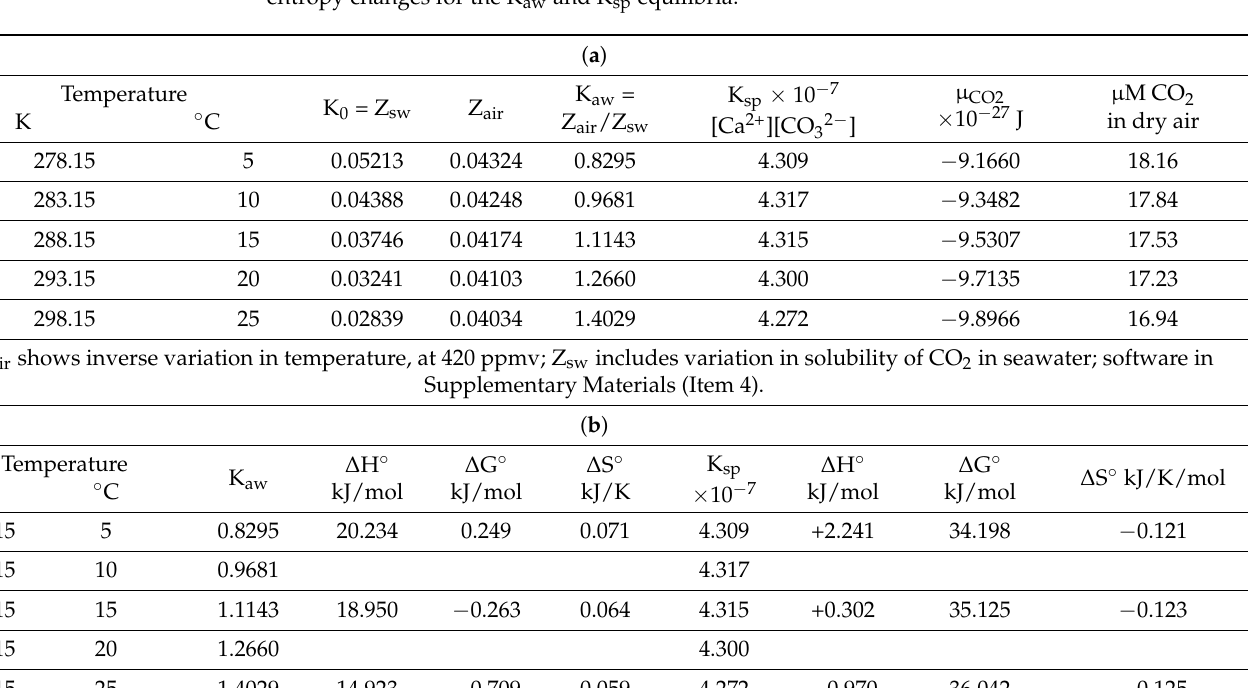
Table 4. ( a ) Modelled estimates of thermodynamic variation of key constants with temperature of seawater and its concentration using the Thermal model; ( b ) Standard enthalpy, Gibbs energy and entropy changes for the K aw and K sp